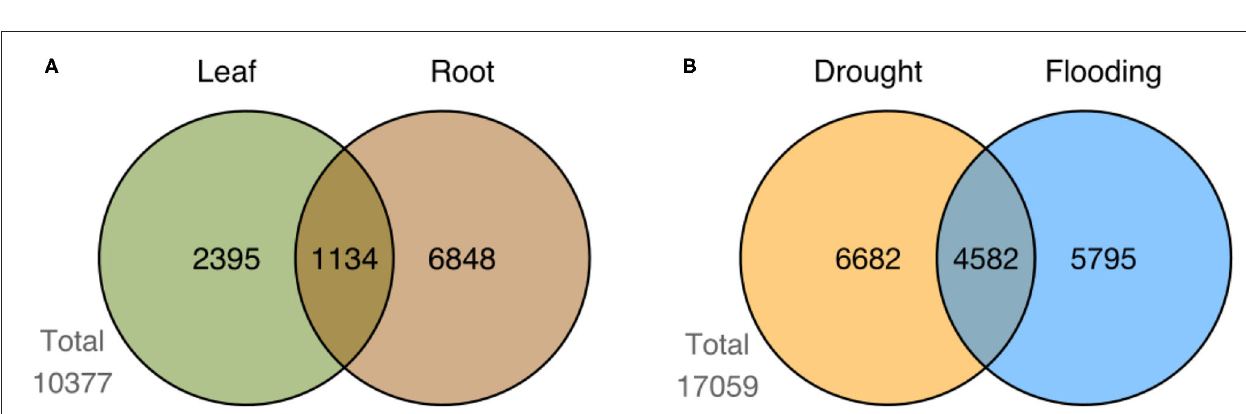
FIGURE 5 | Summary of shared and exclusive DEGs identified in comparisons between control vs. stress treatments of genotypes from both drought and flooding conditions. Figure shows the number of DEGs from tolerant (CC 93-7711 and SP 71-6949) and sensitive (MZC 74-275) genotypes to the drought condition obtained in (A) root tissue; and the number of DEGs from tolerant (CC 01-1940) and sensitive (CC 93-4418) genotypes to the flooding condition identified in (B) leaf and (C) root tissue.